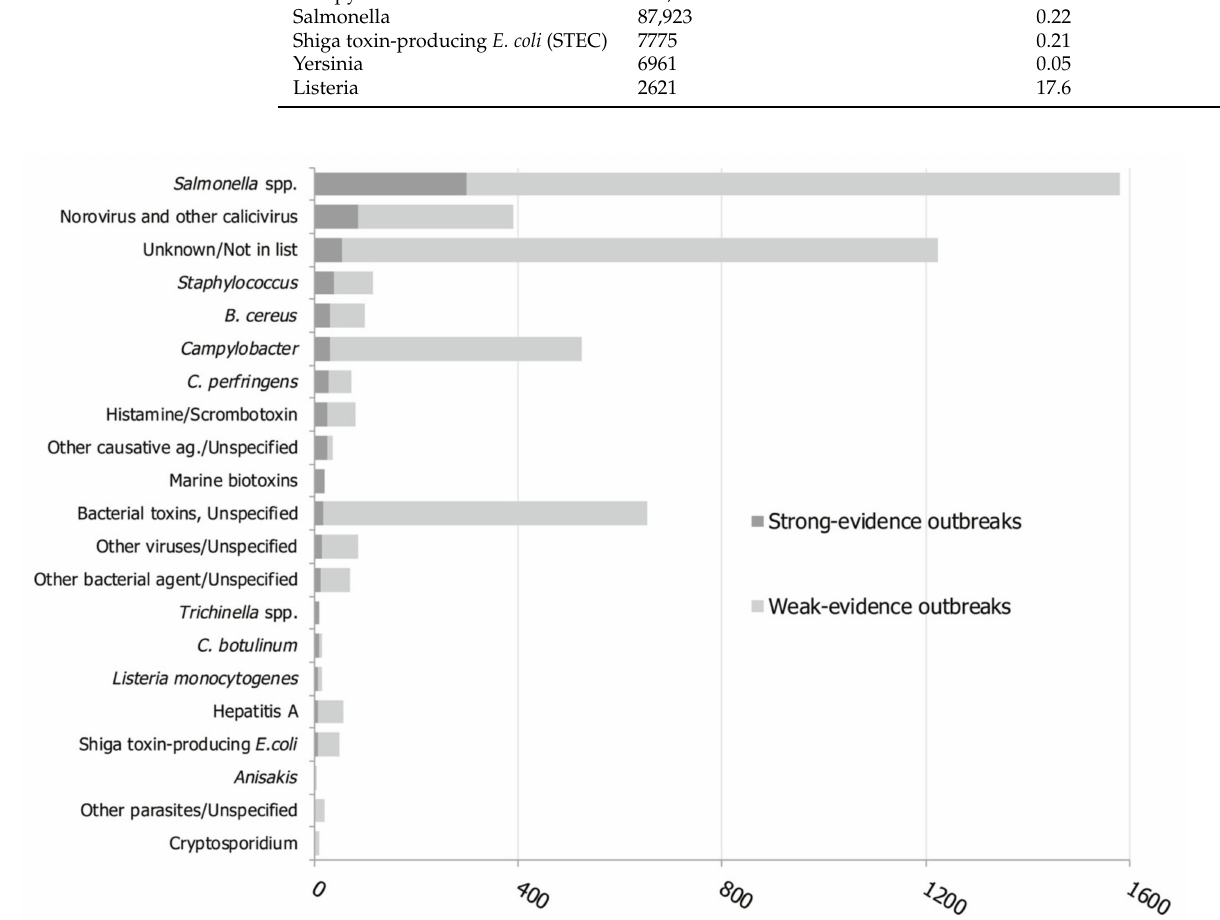
Figure 1. Food and water-borne outbreaks, i.e., cases in which ≥ 2 persons fell ill from the same food and the same agent, per causative pathogen in 2018 in the EU and associated countries. The explanation of “other” relevant for this paper is as follows. Other bacteria include Aeromonas hydrophila , (enteroinvasive (EIEC) or enterotoxigenic (ETEC)) Escherichia coli , Enterococcus , Leptospira spp., Shigella spp., Shigella flexneri , Shigella sonnei , Yersinia enterocolitica , and unspecified bacteria. Other viruses include adenovirus, flavivirus, hepatitis E virus, rotavirus, and unspecified viruses. Other parasites include Giardia intestinalis ( lamblia ), Giardia spp., Taenia saginata , and unspecified parasites. Figure courtesy of EFSA from